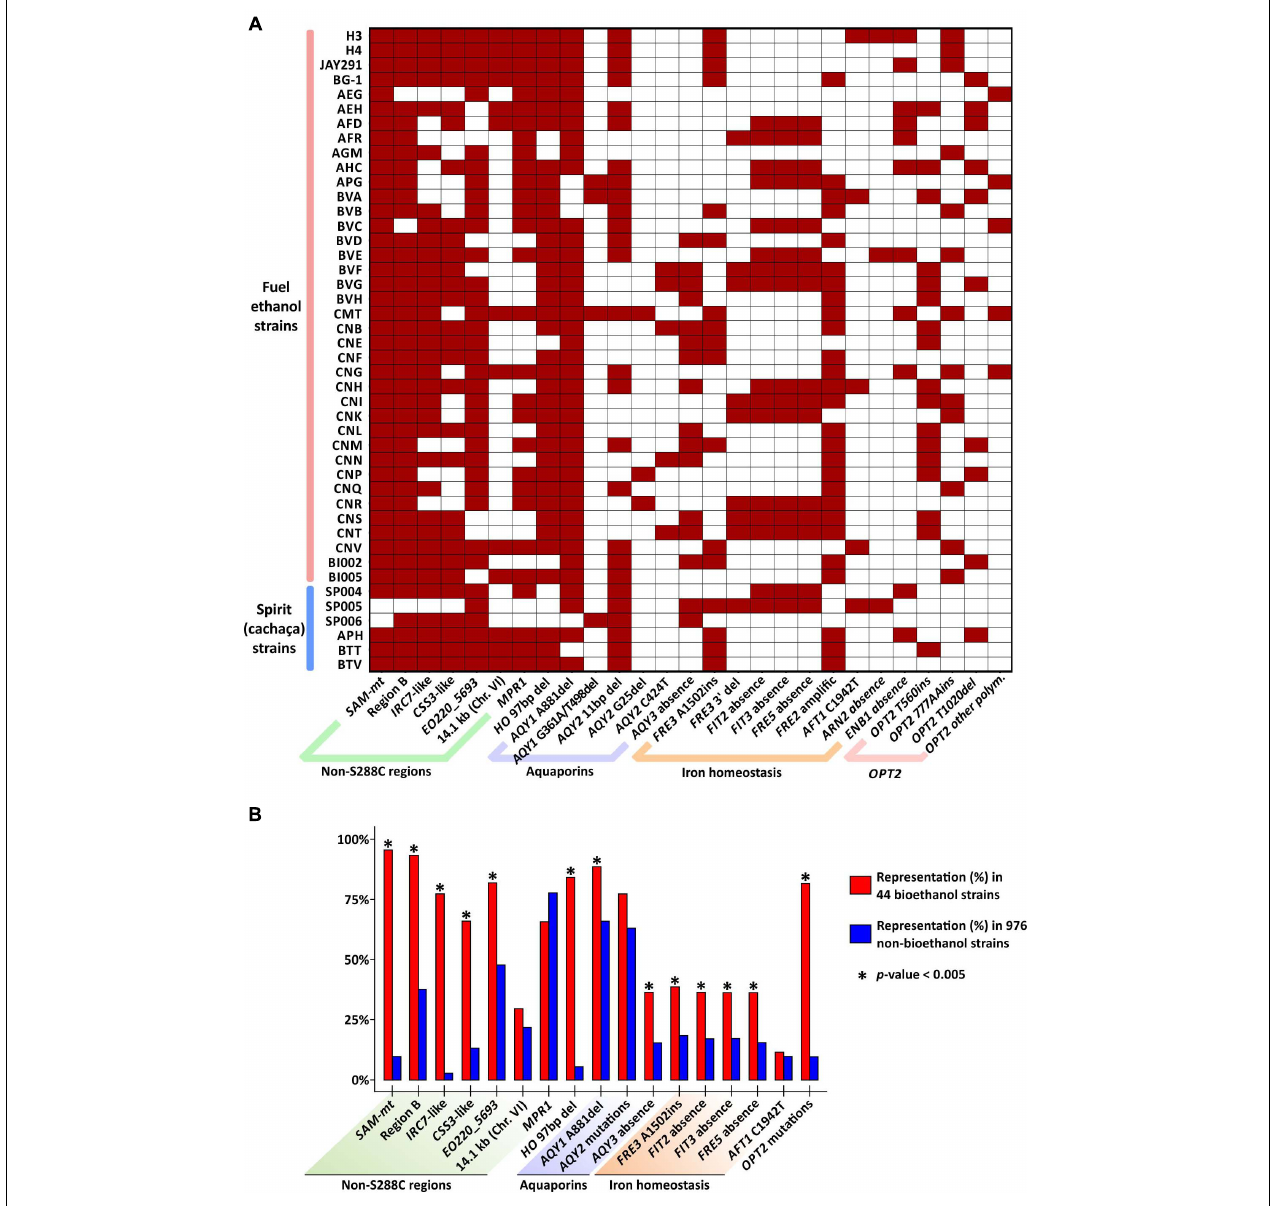
FIGURE 3 | Genetic features enriched among yeasts of the bioethanol group. (A) The presence of key genetic features (represented on the x-axis by non-S288C genes/regions, loss-of-function alleles, and absence of specific genes) was determined in 44 strains (y-axis) by BLASTN searches. The color scheme depicts the presence (dark red) or absence (white) of the feature for each strain. S. cerevisiae isolates are described in the Supplementary Table 1 . (B) Enrichment of each genetic feature in 44 strains from the bioethanol group (percentage of representation shown in red bars). For comparison, BLASTN searches were also conducted against a dataset of 976 strains and the fraction of presence for each genetic feature is shown in blue bars. AQY2 and OPT2 mutations combine the polymorphisms shown in panel (A) . Asterisks (*) indicate significant enrichment of the feature among yeasts of the bioethanol group (Fisher’s exact test, p <